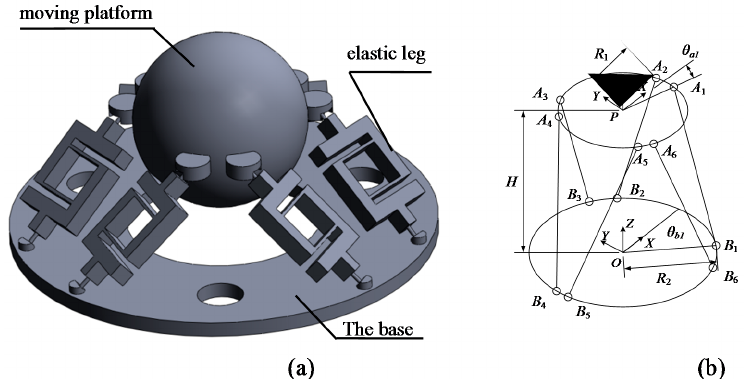
Figure 1. Structure of the six-axis accelerometer: ( a ) three-dimensional model of a small range six-axis accelerometer; and ( b ) theoretical model of the six-axis accelerometer.